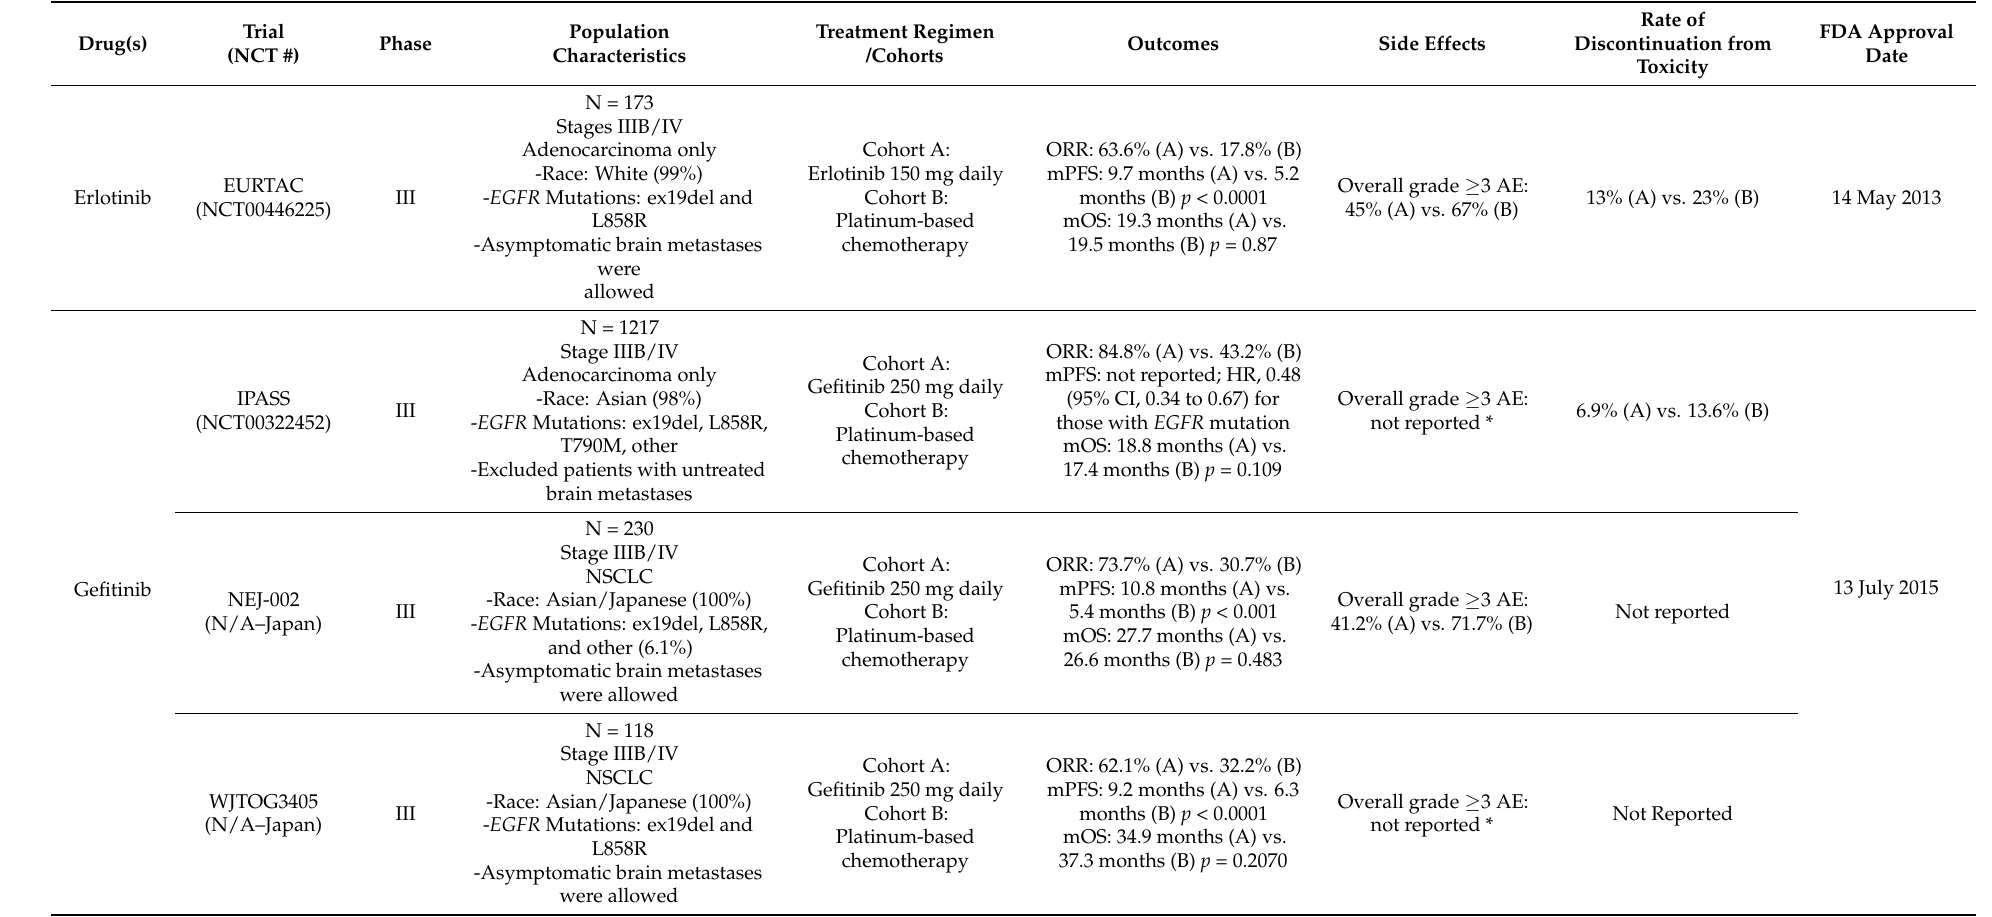
Table 1. Landmark Clinical Trials of EGFR TKIs as First-Line Therapy for Advanced